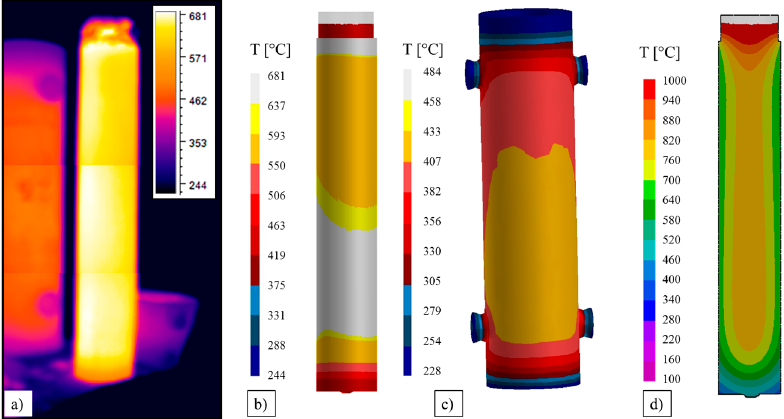
Figure 13. Temperature of the ingot on the surface just after the stripping phase: ( a ) measured by the thermo-camera; ( b ) simulated on the ingot; ( c ) simulated on the mold; and ( d ) temperature along the middle longitudinal section.